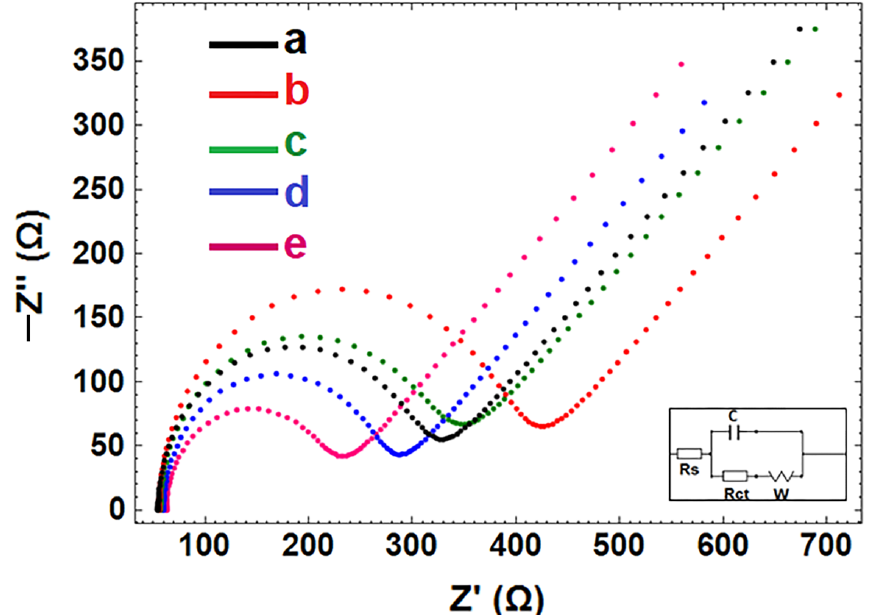
Figure 7. Nyquist diagrams recorded after (a) 0.1 μg/mL DNA - Apt immobilization onto CNF - IL modified electrode and aptamer interaction with 0.6 μg/mL of (b) APC, (c) PC, (d) THR, (e) BSA in 1:2000 diluted FBS.